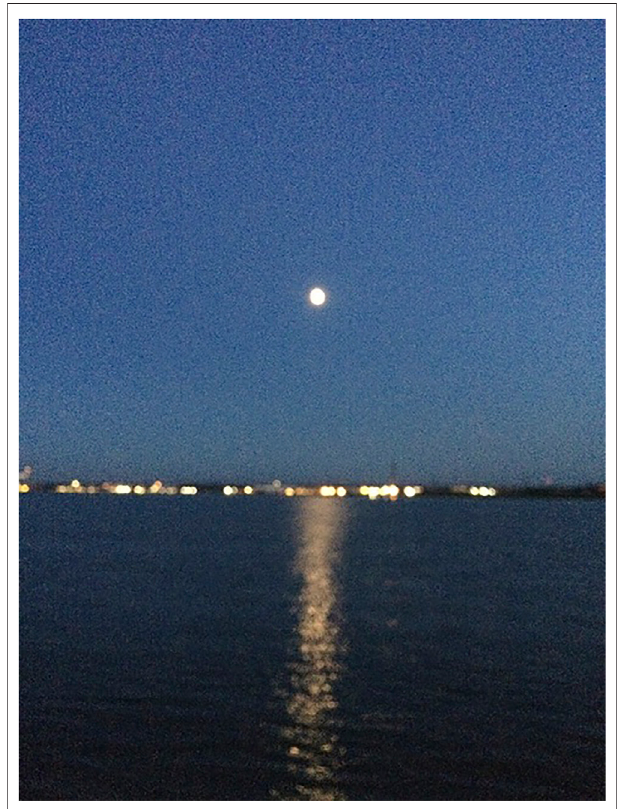
FIGURE 2 | “ I always feel calm when I look at the moon. Sometimes the moon over London is pretty, and I fi nd solace over them, no matter where I am. ”